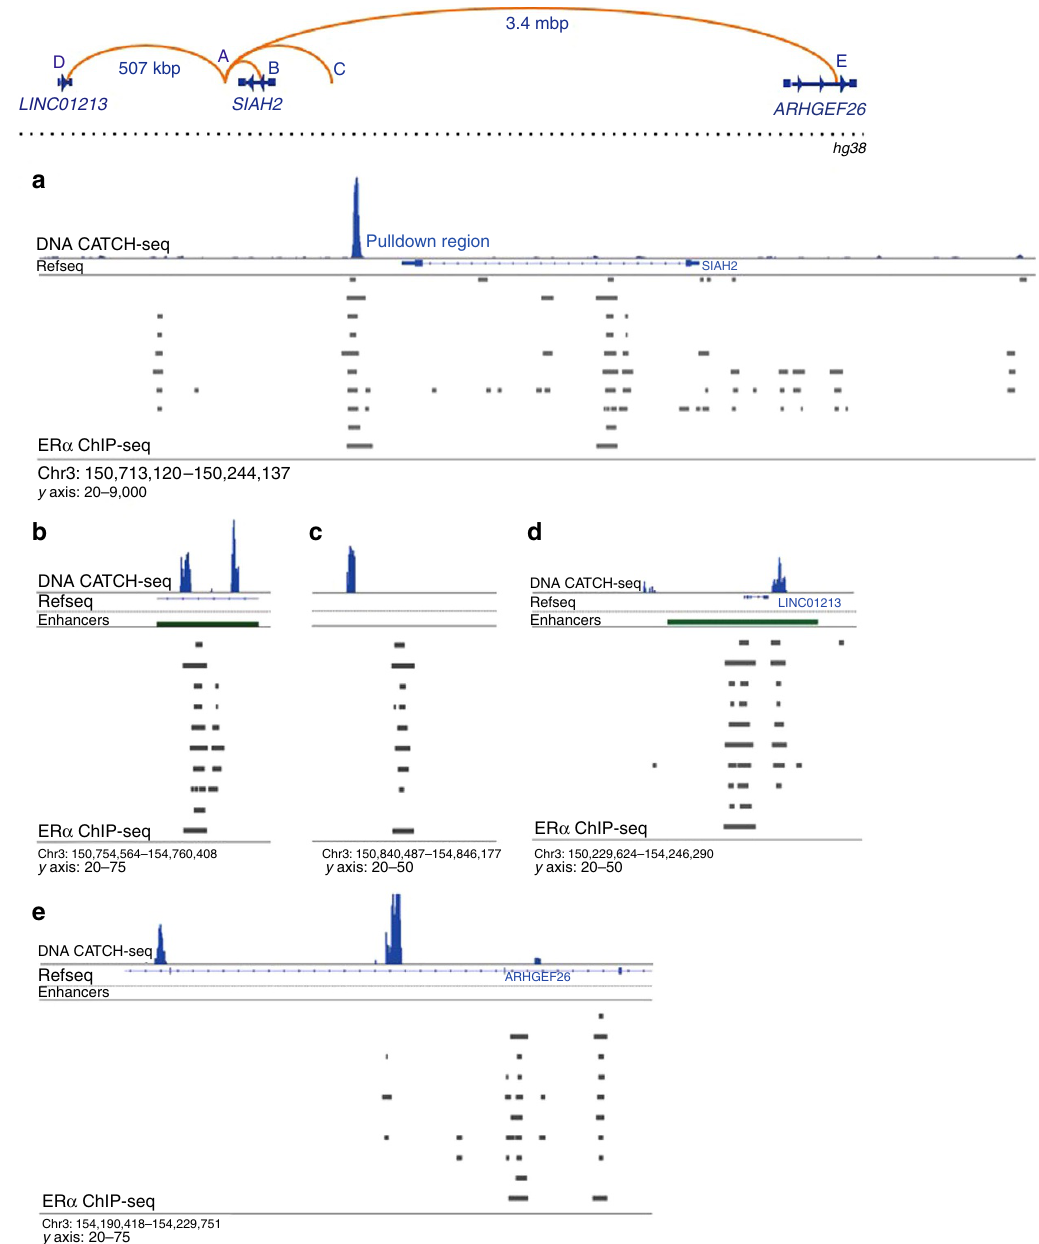
Figure 2 | CATCH recapitulates chromatin interactions detected with ER a ChIA-PET. Top diagram: the diagram represents the linear distances between ( a ) the downstream enhancer of SIAH2 , ( b ) a SIAH2 intronic ERE and ( c – e ) three additional sites shown, using ChIA-PET, to have interaction with site A in MCF-7 cells. The y axis labels below integrative genomics viewer (IGV) histograms represent the number of sequencing reads after background subtraction. Subpanels: ( a ) the CATCH-seq pull-down region, also an enhancer downstream of SIAH2 , is demonstrated to be highly enriched after CATCH- seq, confirming the efficacy of the capture method. ( b ) The SIAH2 intronic ERE, as denoted by the presence of ER a -binding sites detected by 10 different studies (grey bars, data sets outlined in the Methods section), was positive for two different interactions flanking the known ER a -binding regions. ( c ) The downstream ERE shows interaction with an ER a -binding region upstream of SIAH2 ; the location of the interaction was B 2kb from the ER a -binding site according to CATCH-seq. ( d ) An ER a -binding site near LINC01213 and ( e ) a region of ER a binding within ARHGEF26 both show interaction with the SIAH2 downstream ERE, as previously demonstrated by ref.